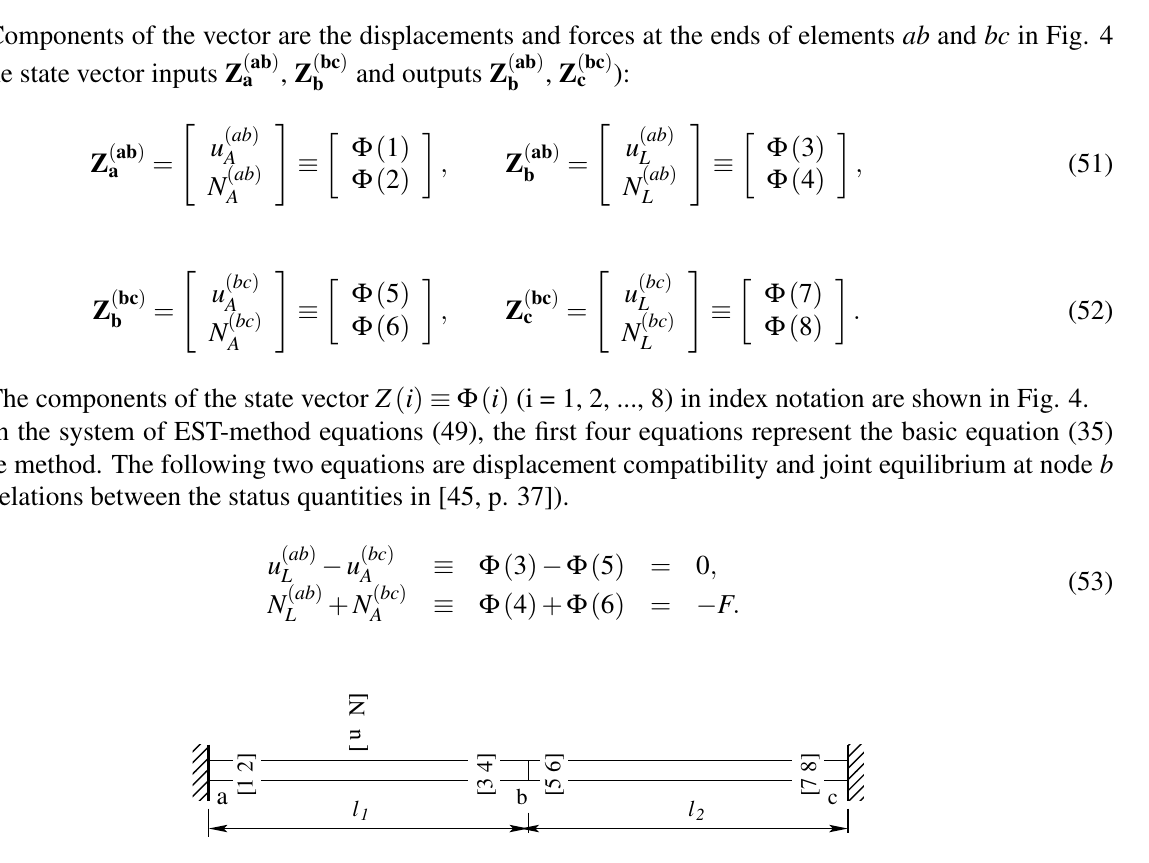
Fig. 4. Displacement and force indices of two bar-elements.